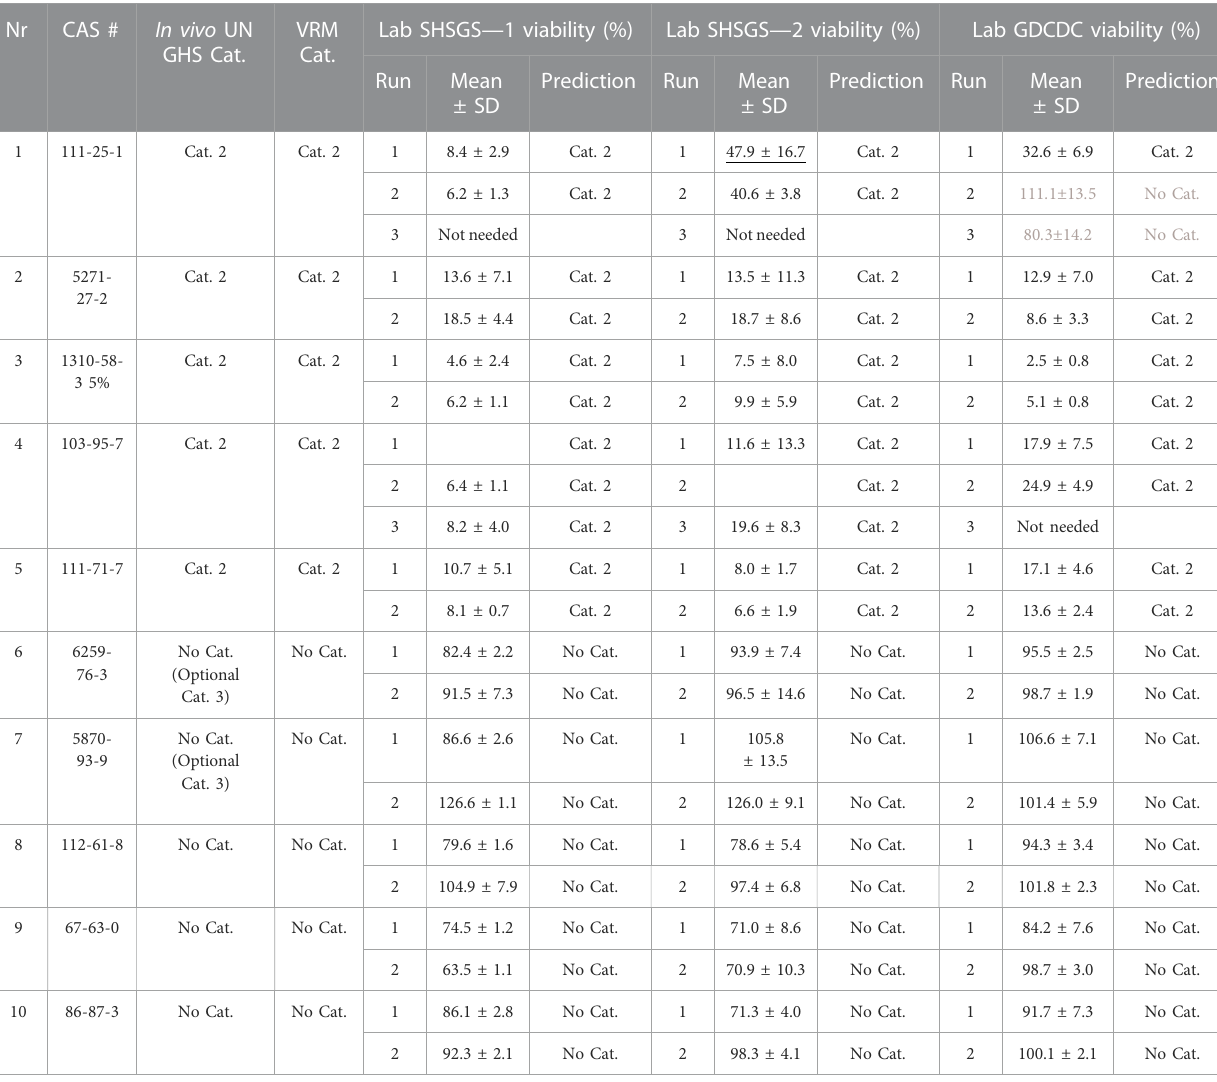
Prediction Mean ± SD